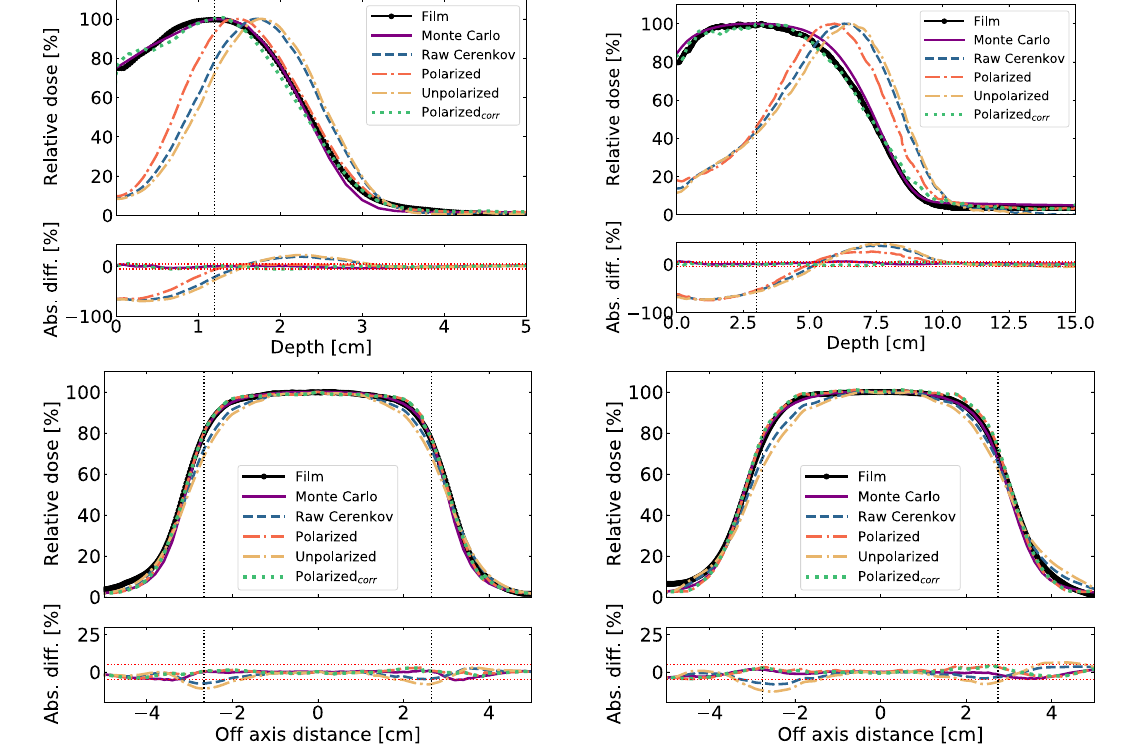
Figure 4. Electron beams projected percent depth dose (top) and profiles (bottom) compared with dose measured from radiochromic films. Monte Carlo results are also presented for comparison. Vertical dotted lines indicate the position of maximum dose, while horizontal red dotted lines indicate a ± 5 % difference region.Left and right figures respectively present results from 6 MeV and 18 MeV beams.